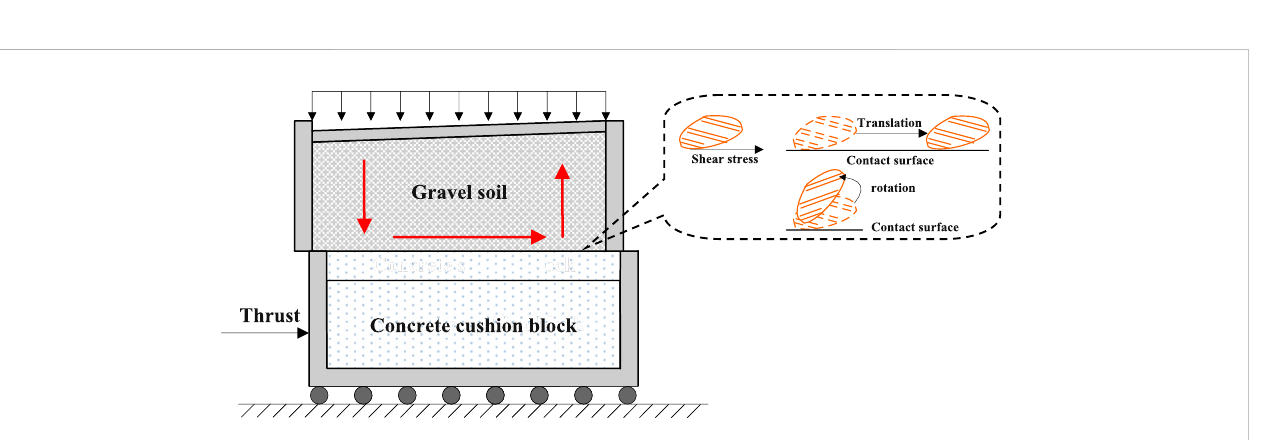
FIGURE 19 Soil grain movement during the shearing process.